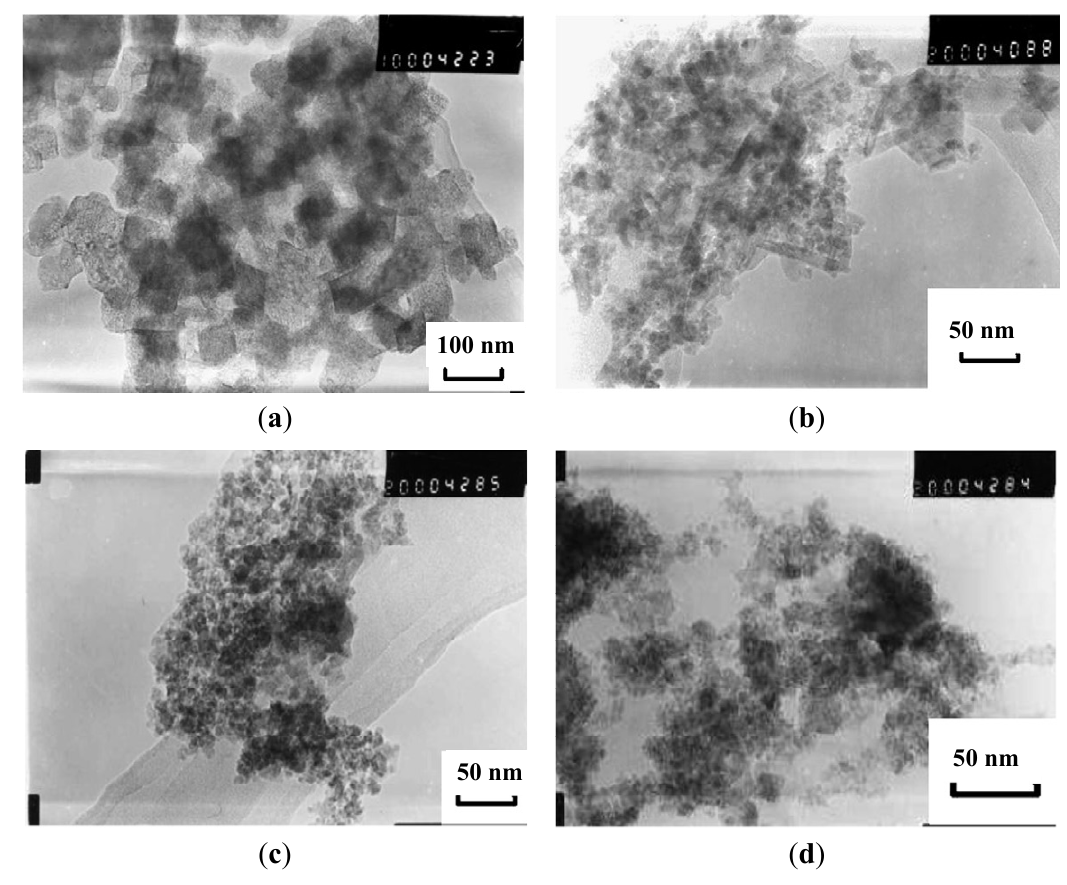
Figure 13. TEM of magnetic NPs (MNPs) obtained with: ( a ) molecular weight (MW) = 5.0 × 10 5 g∙mol −1 non cross-linked chitosan; ( b ) cross-linked; ( c ) MW = 1.0 × 10 5 g∙mol −1 non cross-linked chitosan; ( d ) cross-linked. Reprinted with permission from [38]. Copyright 2006 Elsevier